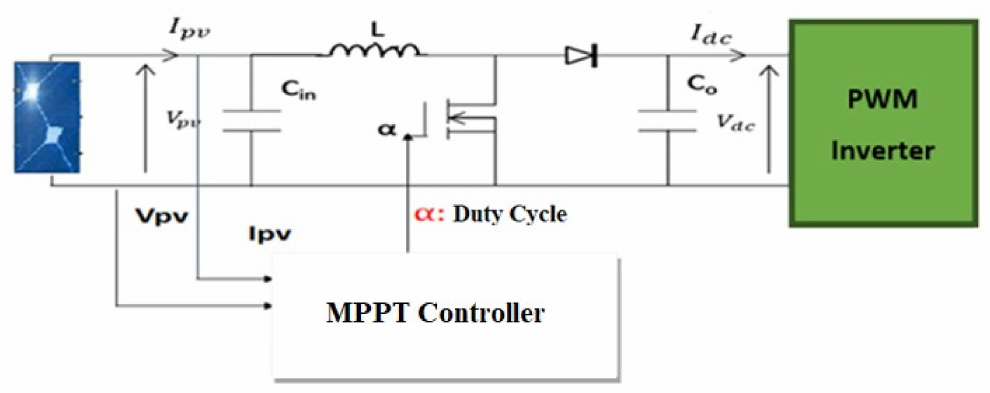
Figure 3. Equivalent circuit of the boost